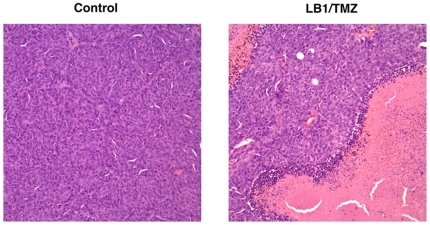
Histolopathology.Histologic features of liver PHEO lesions stained with H&E 24 hours after i.p. vehicle alone (left) or with i.p. LB1 at 1.5 mg/kg plus TMZ by gavage at 80 mg/kg (right). Exposure to a single i.p. injection of vehicle showed a homogeneous field of healthy appearing tumor cells, whereas combination treatment resulted in extensive necrosis of tumor cells.